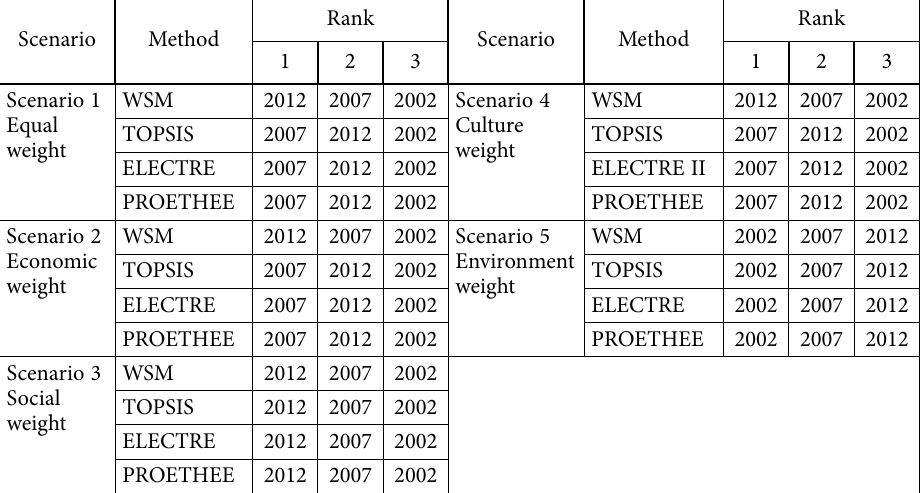
Table 8. The rankings in terms of different methods and scenarios Scenario